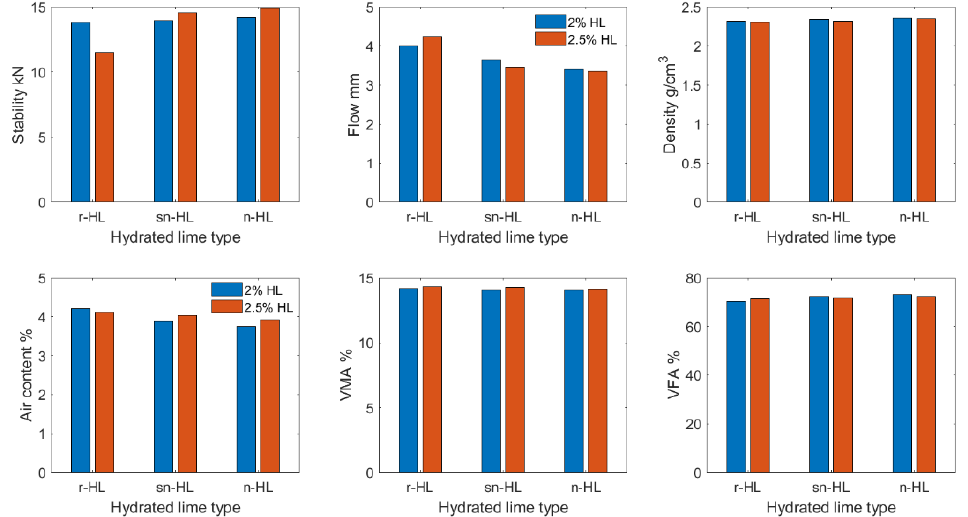
Figure 19. Marshall Properties at 2.0 and 2.5% HL.